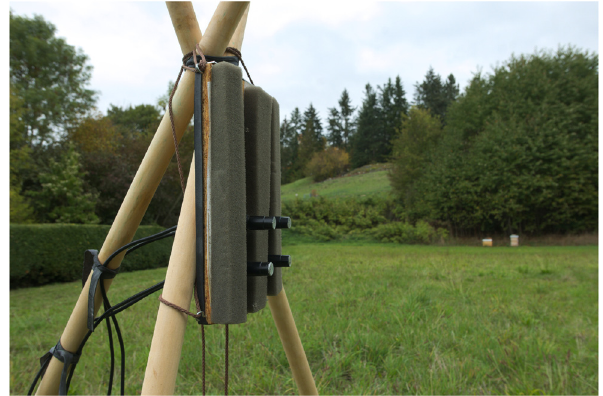
Figure 1. Setup used for testing microphone attachments outdoors. The microphones were approximately 1 m above the ground and parallel to each